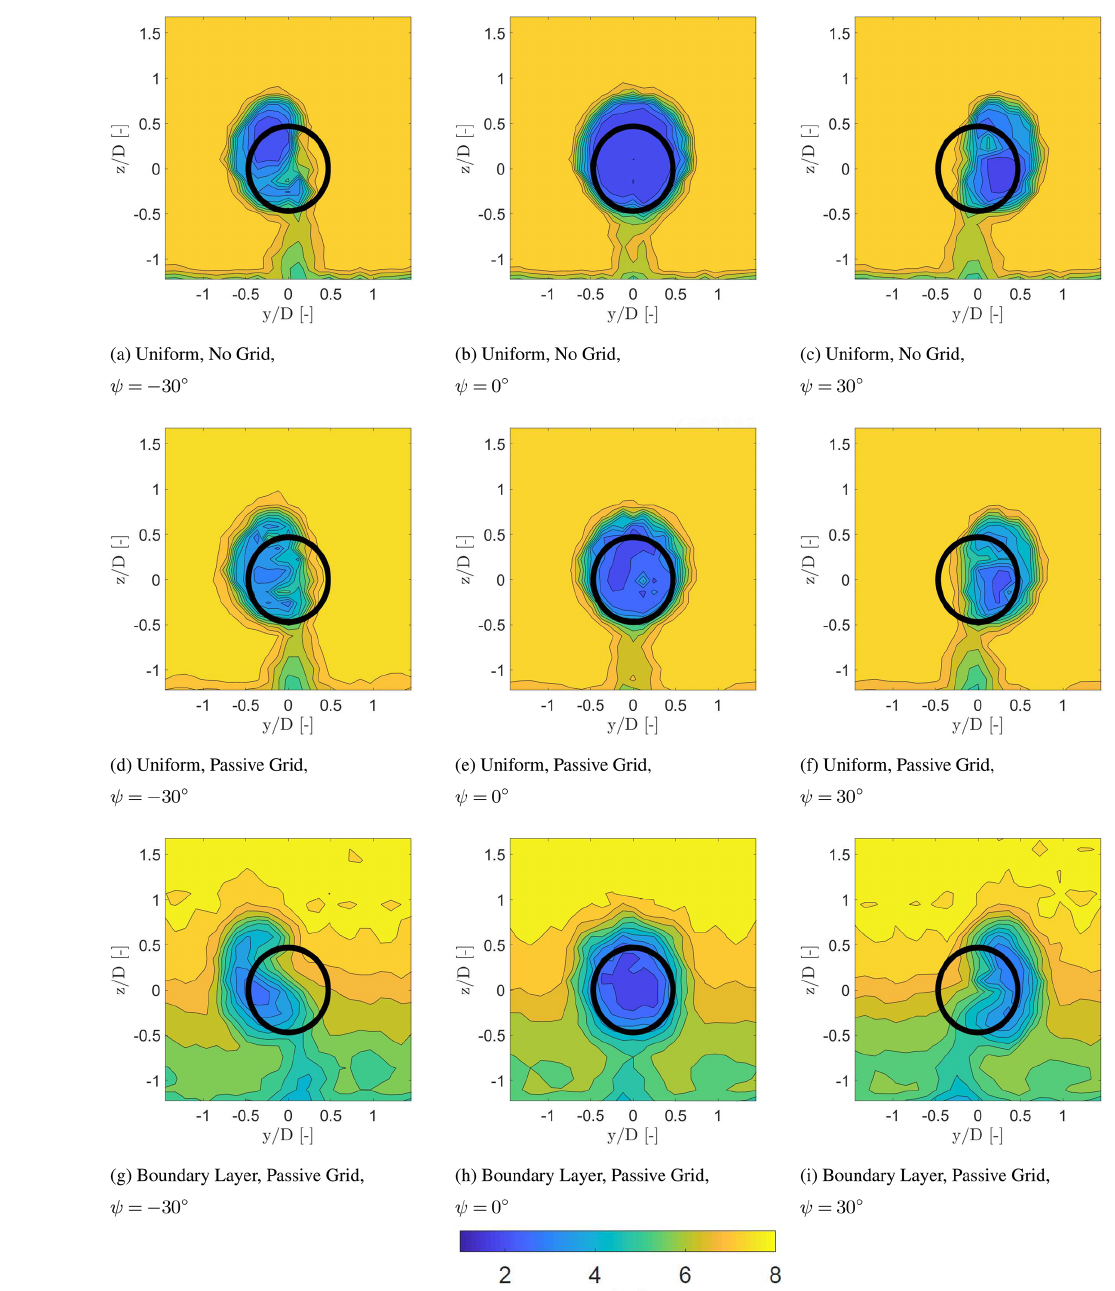
Figure 4. Temporally averaged streamwise velocity component at a downstream distance of 2 D for different inflow conditions. The wake is viewed looking upstream towards the turbine